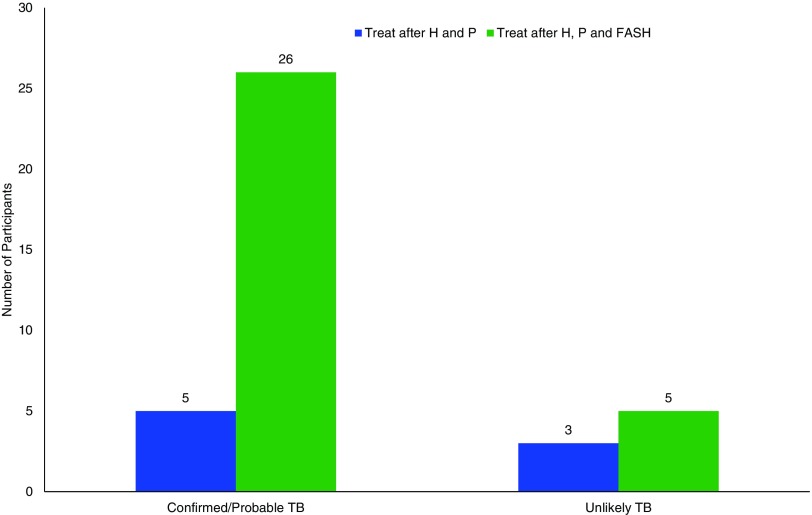
Comparison of Clinicians' Decision to Empirically Treat TB in Participants at 2 Time Points at an Urban Medical Center, Lilongwe, Malawi, by TB CategoryaAbbreviations: FASH, focused assessment with sonography for HIV-associated tuberculosis; H, history; P, physical exam; TB, tuberculosis.aTB categories determined by study authors after 6-month follow-up.